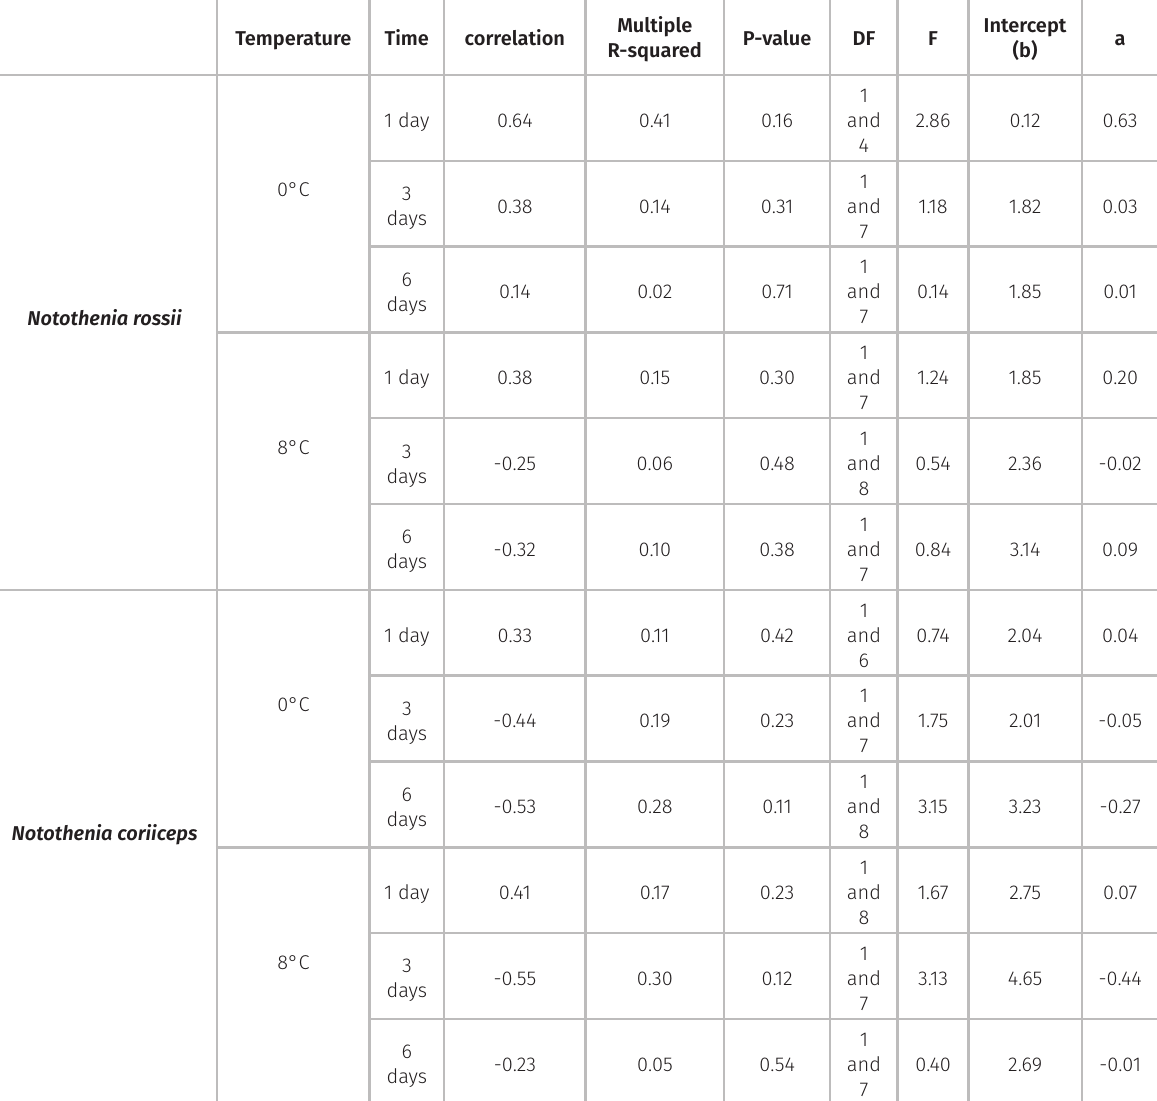
Table I. Correlation and coefficients of the linear regression model of oxidative stress and morphological alterations of N. rossii and N. coriiceps at 0°C and 8 ° C, for 1, 3 and 6 days. Temperature Time